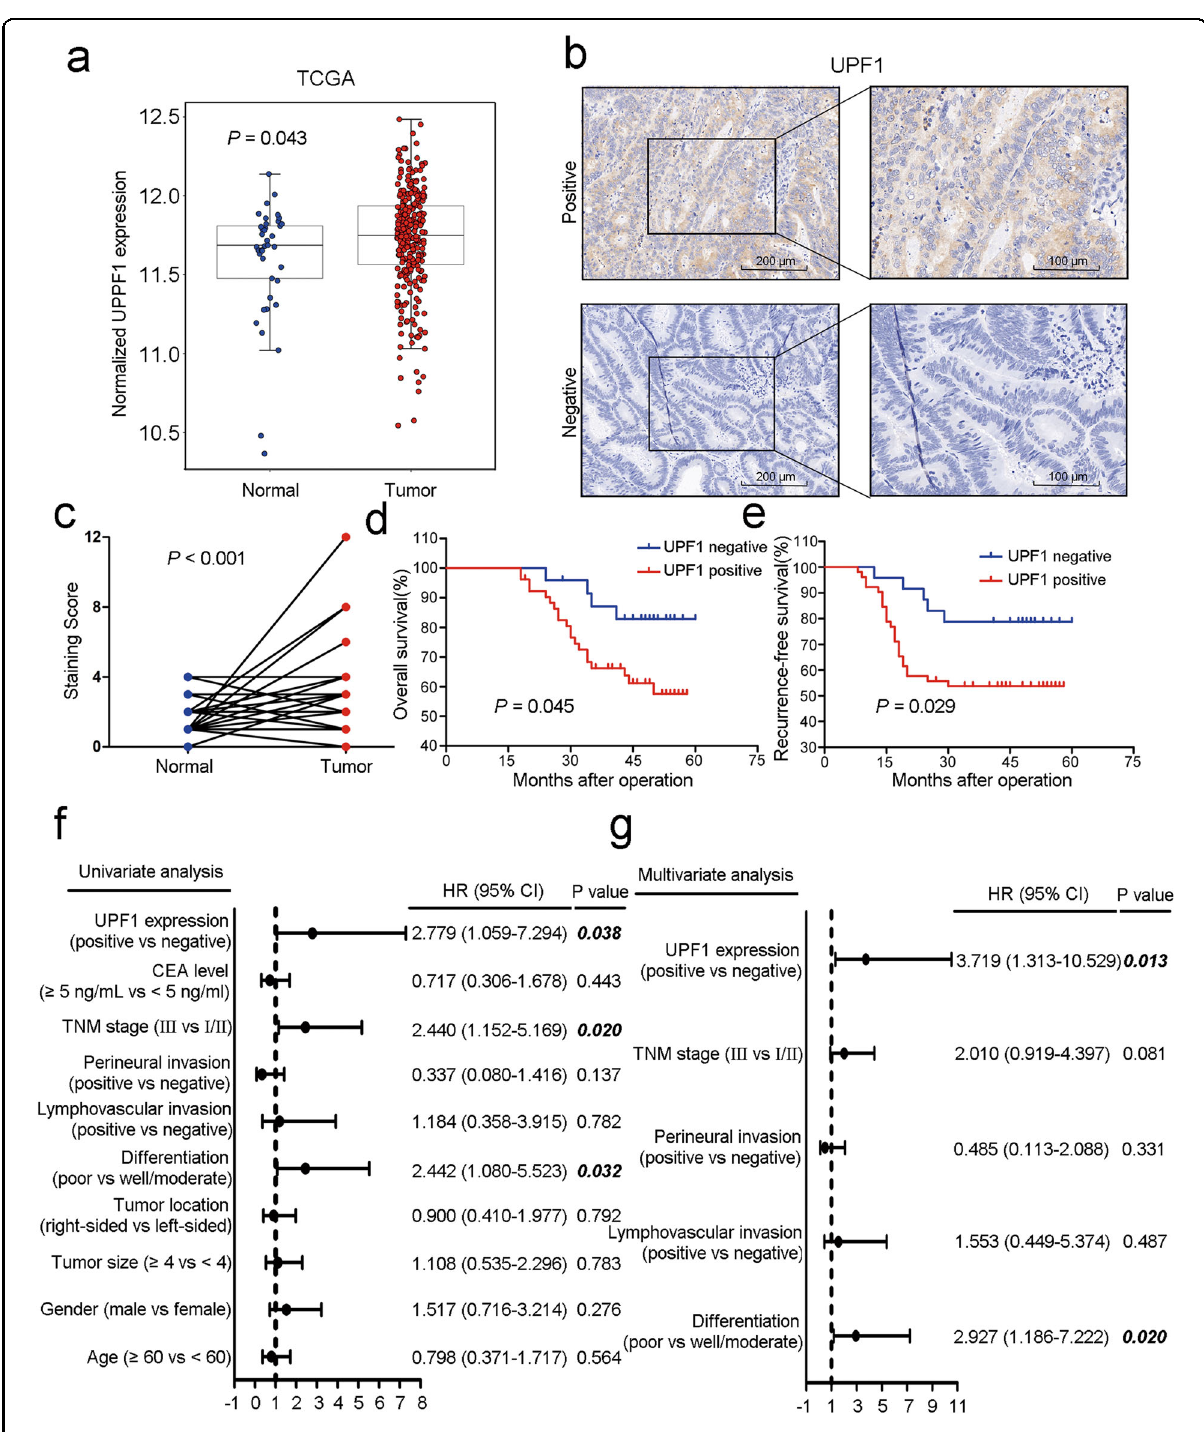
Fig. 1 UPF1 is upregulated in CRC and predicted a poor prognosis. a UPF1 was overexpressed in CRC tissues in mRNA level from TCGA datasets. b Images of UPF1 in IHC staining in CRC tissue microarrays, scale bar, 200 μ m and 100 μ m. c UPF1 was overexpressed in CRC tissues in protein level by IHC staining in tissue microarrays. d – e UPF1 positive predicted worse OS and RFS in CRC patients. f – g Univariate and multivariate COX regression analysis revealed that UPF1 was an independent risk factor for recurrence in CRC